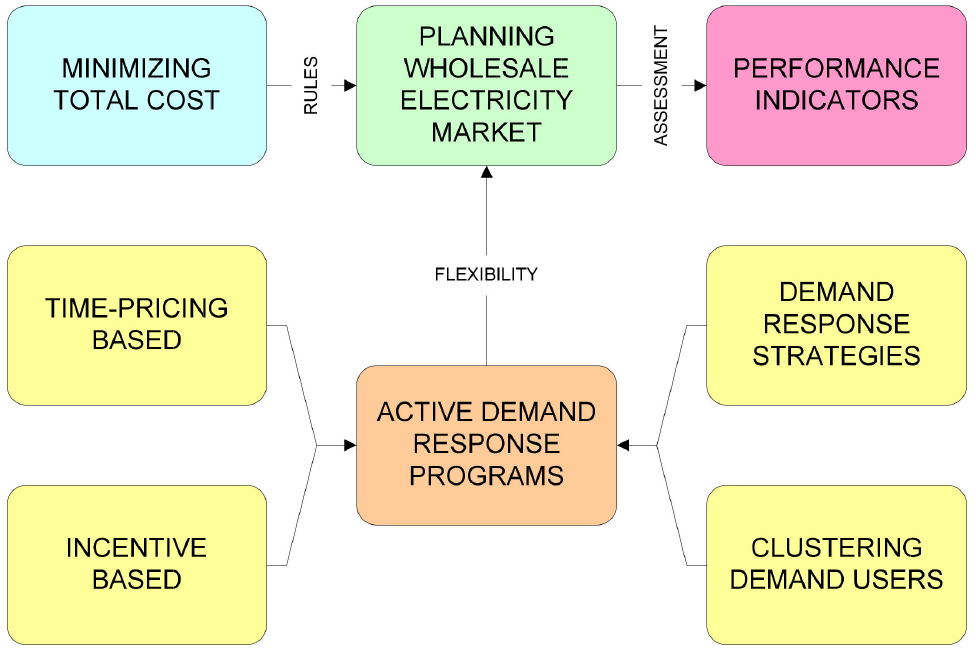
Figure 2. Conceptual map of wholesale electricity market plan implementing demand response.